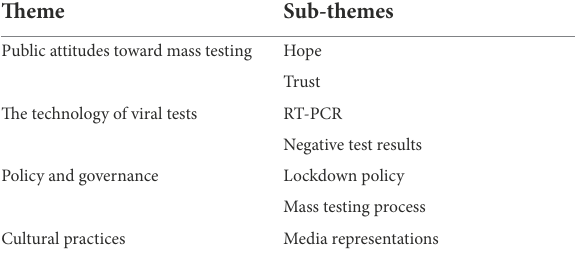
TABLE 2 Coding tree of thematic